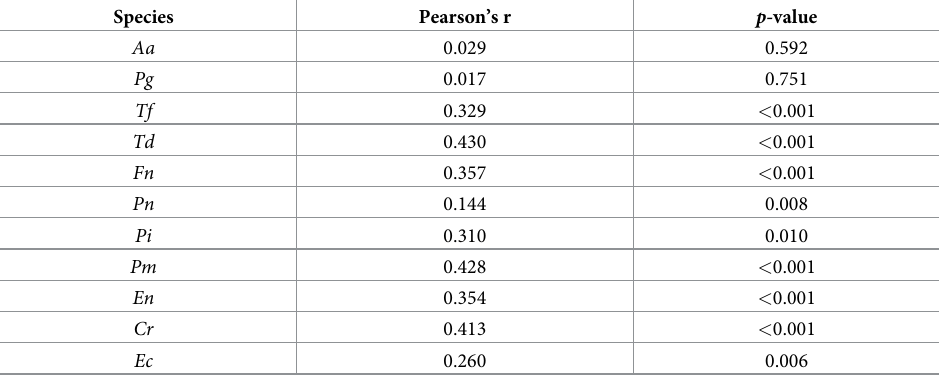
Table 3. Correlation between the severity of periodontal condition and the number of each bacterial species.